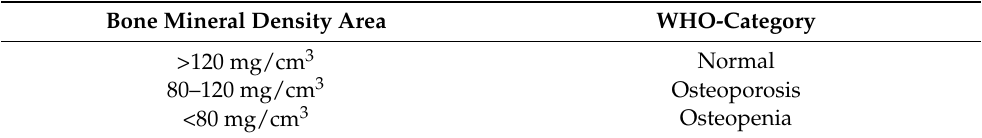
Table 2. QCT Spinal Bone Mineral Density Classification of the American College of